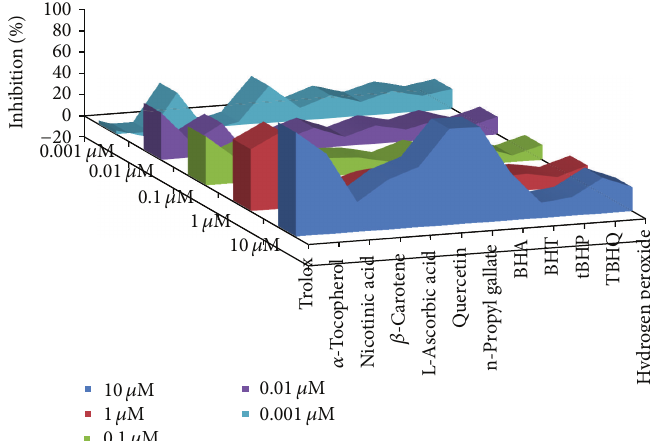
Figure 4: Percent area under curve with respect to control.